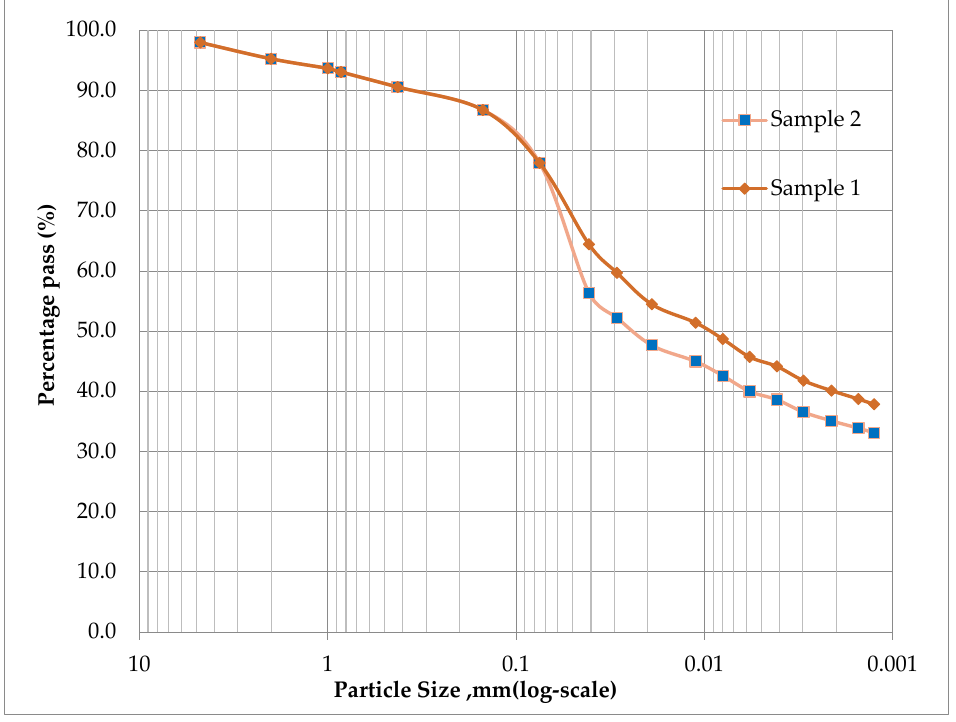
Figure 4. Particle size distribution curve .